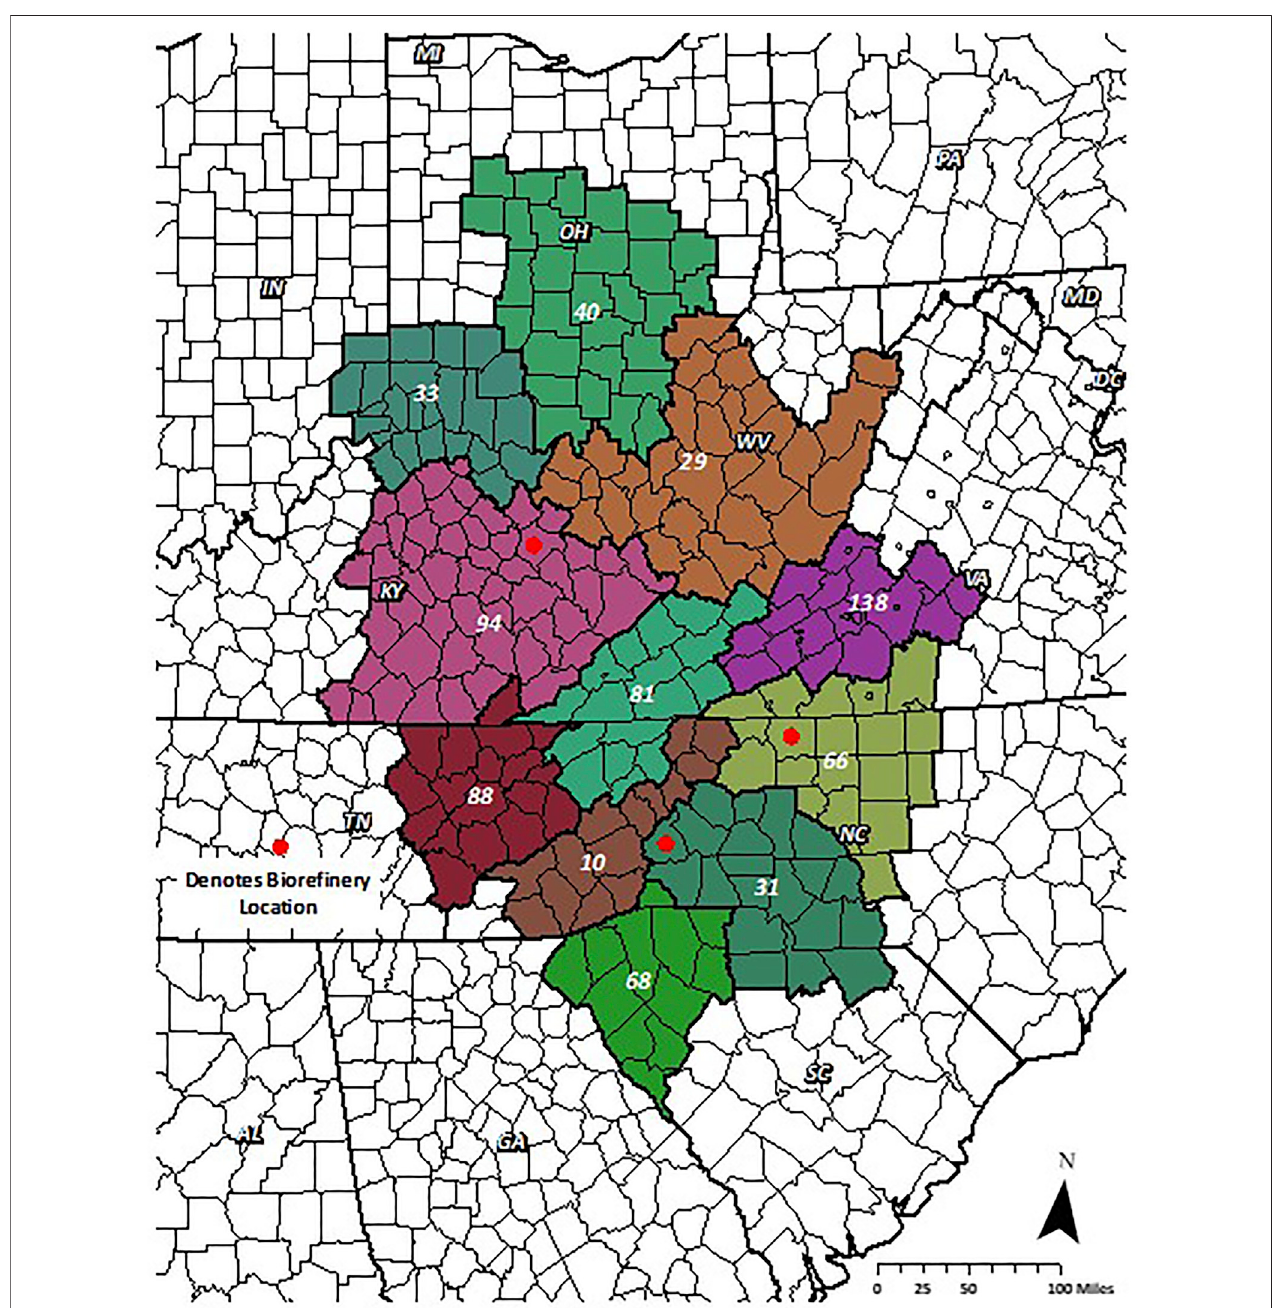
FIGURE 5 | Location of the Central Appalachia feedstock draw areas by Bureau of Economic Analysis regions for the gasi fi cation and Fischer – Tropsch biore fi neries.